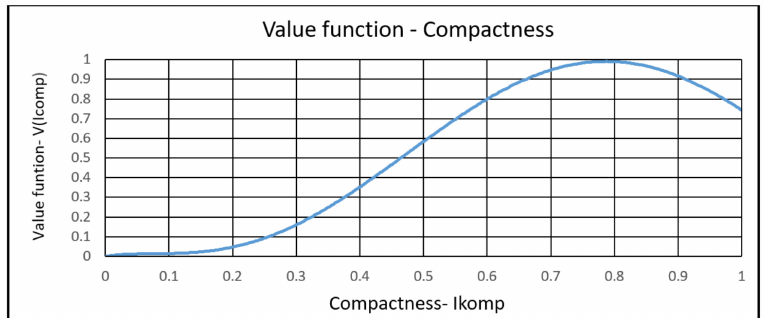
Figure 10. Graph of the value function of cadastral parcel